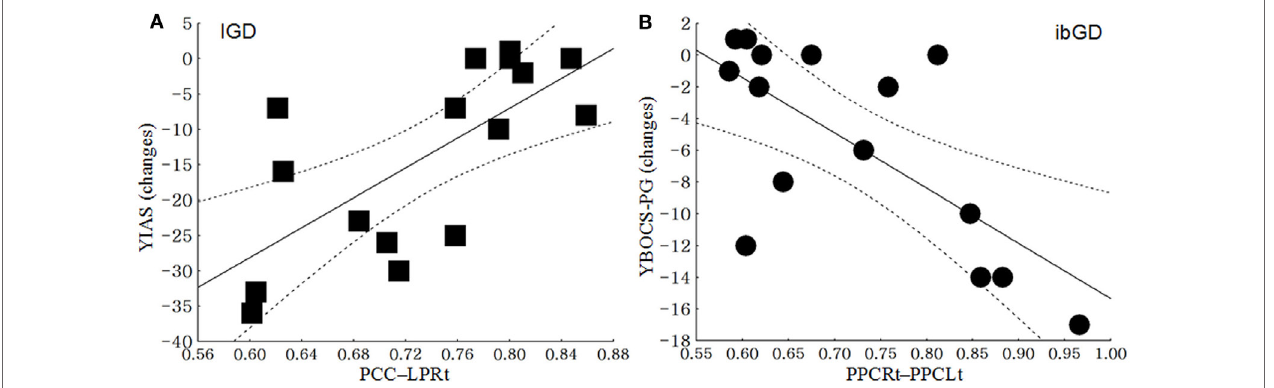
FigUre 3 | Correlation between the changes in clinical scales and the changes in brain functional connectivity. (a) In the Internet gaming disorder (IGD) group, the functional connectivity between the posterior cingulate cortex (PCC) and right lateral parietal cortex (LPRt) was positively correlated with the changes in the Young Internet Addiction Scale scores from baseline to 12 weeks ( r = 0.69, p < 0.01). (B) In the ibGD group, the changes in FC between the left posterior parietal cortex (PPCLt) and right posterior parietal cortex (PPCRt) were negatively correlated with the changes in the Yale-Brown Obsessive Compulsive Scale for pathologic gambling (YBOCS-PG) scores from baseline to 12 weeks ( r = − 0.68, p <